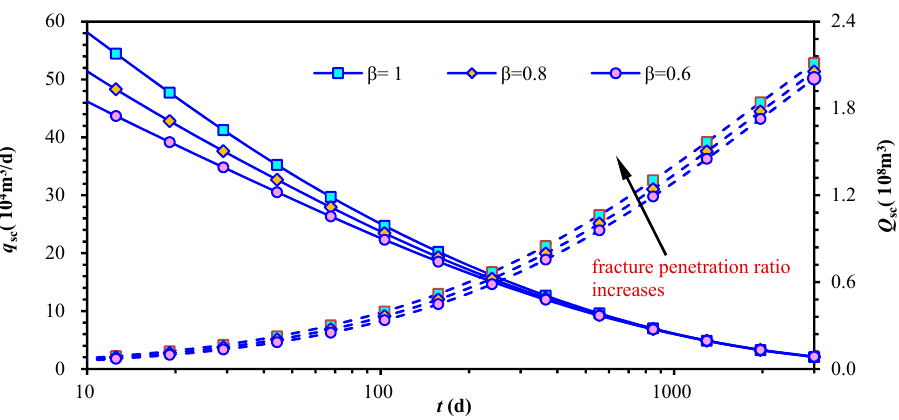
Figure 15. Effect of Hydraulic Fracturing Degree on Production of a MFHW in Shale.